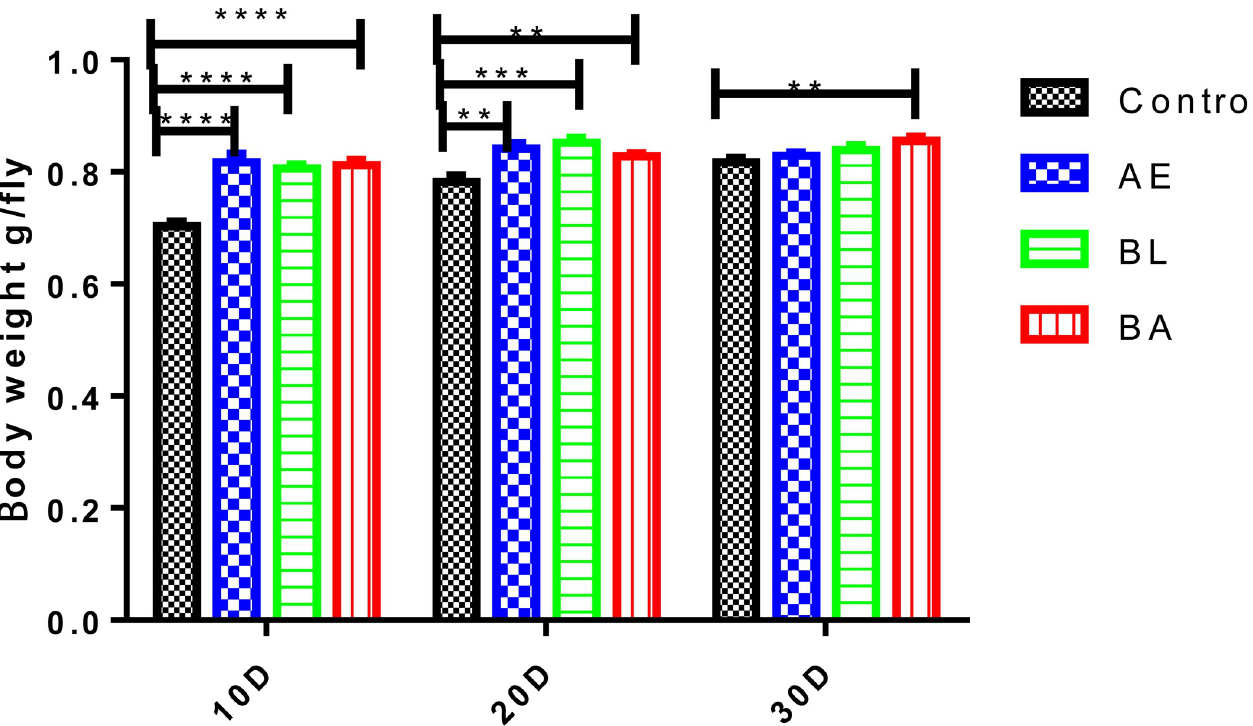
Fig 2. Body weight of InR [E19]/ TM2 D . melanogaster on days 10 (10D), 20 (20D), and 30 (30D) in the four groups. AE: Astragalus membranaceus extract, BL: Bacillus licheniformis and BA: Bacillus licheniformis and Astragalus membranaceus extract. 10D, 20D and 30D represent InR [E19] /TM2 D . melanogaster growth at 10, 20 and 30 days in each group,